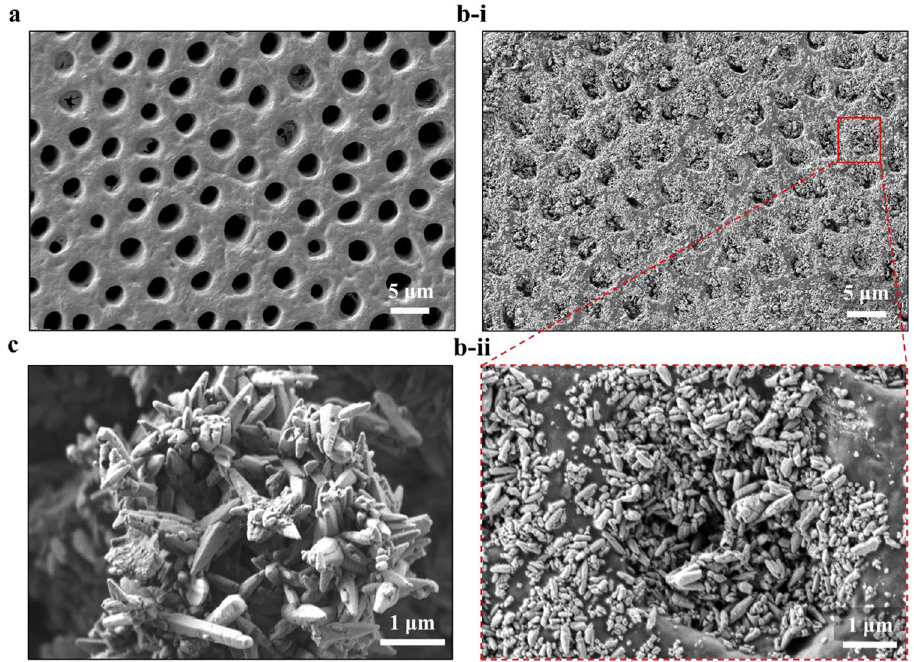
Figure 1. SEM images displaying ( a ) the surface of the cleaned dentinal specimen before applying the testing toothpaste; ( b ) the surface of the treated dentin disc showing occlusion by the test toothpaste under low magnification ( b-i ) and high magnification ( b-ii ); and ( c ) the morphology of raw material used for forming the testing